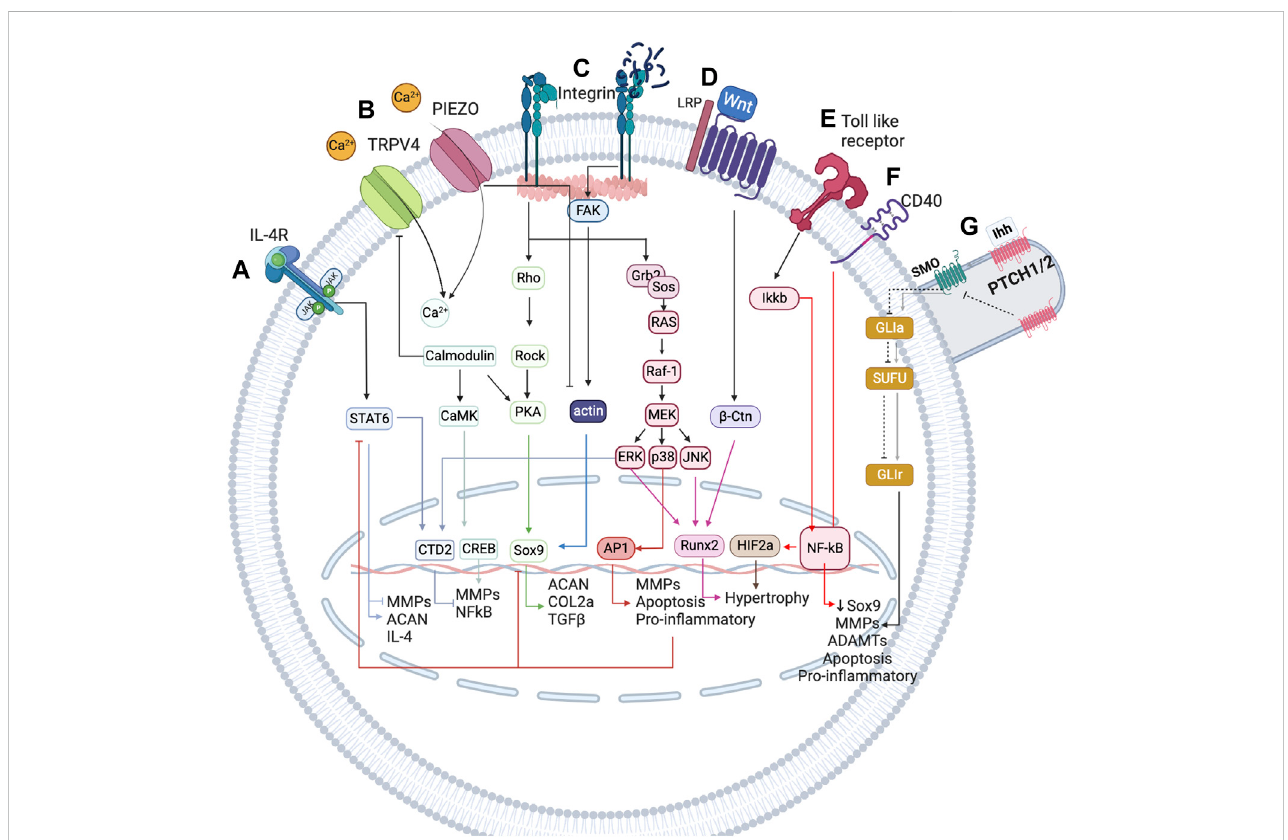
FIGURE 2 Simpli fi ed representation of the network-based modelling of the main mechanotransduction pathways, coupled with a simpli fi ed overview of the in fl ammatory complexity surrounding chondrocytes, to integrate mechanical stimulation effects on chondrocyte activity. (A) IL-4 is induced by physiological regulation through integrin α 1 β 5 activation. This integrin leads to the expression of SP, which is involved in the expression of IL-4 cytokine, which in turn is the cornerstone for the homeostatic regulation of chondrocytes. (B) TRPV4 is a calcium channel that is pivotal in the chondrogenic phenotype as it is involved in the expression of Sox9. (C) PIEZO channels are mechanosensors involved in the regulation of the chondrocyte upon injurious mechanical loadings. These channels induce a high change in Ca 2+ concentration inside the chondrocyte and seem to induce the denaturalization of the actin cytoskeleton, important for the expression of Sox 9, the principal chondrogenic transcription factor (not depicted in this Figure). (D) Integrins are very important in chondrocyte mechanoregulation because they are in constant contact with the extracellular matrix (ECM), being sensitive to changes in this matrix. When theECM is damaged, RGD peptides increase and induce aconformational change in integrins that promotes thede-polymerization ofactin. (E) Wnt seems to induce a catabolic change on the chondrocyte by activation of NF- κ B transcription factor (a key in fl ammatory transcription factor) through β - catenin. (F) Toll-like receptors perceive damage signals (in fl ammation, pain or degradation products) and promote the expression of NF- κ B, as well as CD40. (G) The primary cilium is an organelle that has a higher accumulation of mechanosensors (not only the path shown). The principal pathway associated are PTHC and PTHrP (not depicted). The fi rst is induced upon injurious loads and contributes to chondrocyte metabolism, whereas the last is believed to be necessary for chondrocyte homeostasis as it is involved in the expression of Sox9. Created with BioRender.com